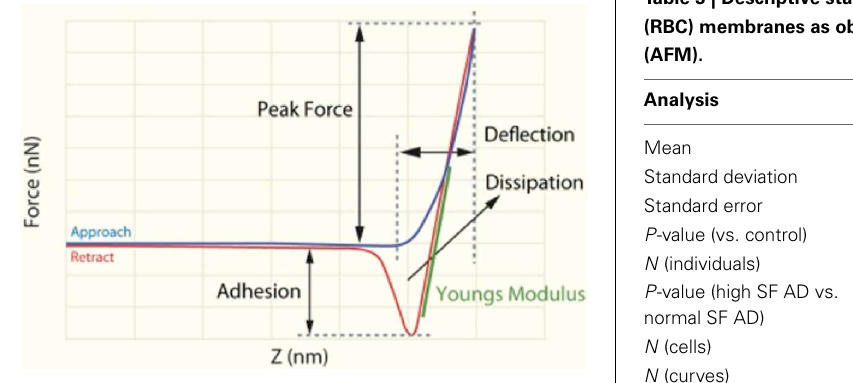
FIGURE 2 | Schematic representation of force/separation plot illustrating the type of the information that can be obtained [adapted and redrawn from Berquand (2011)].